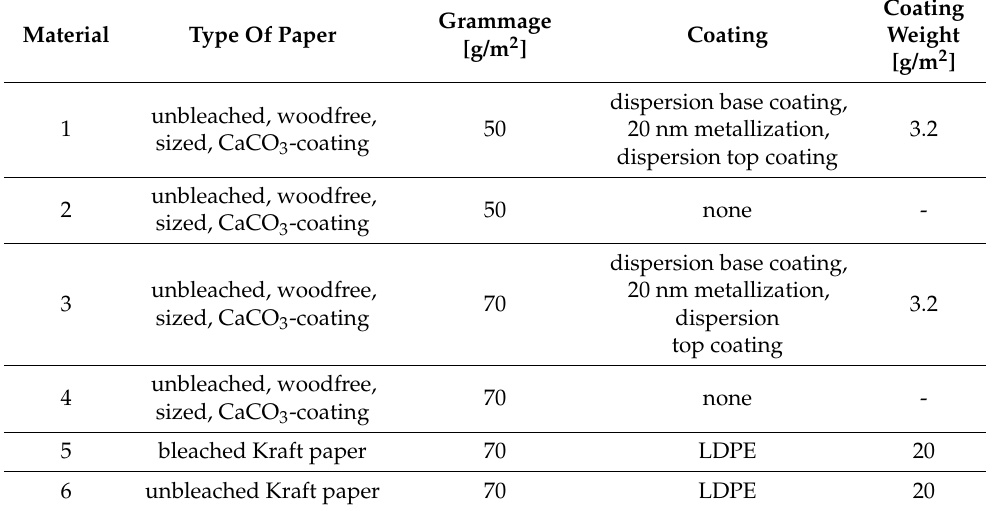
Table 1. Specifications of experimental